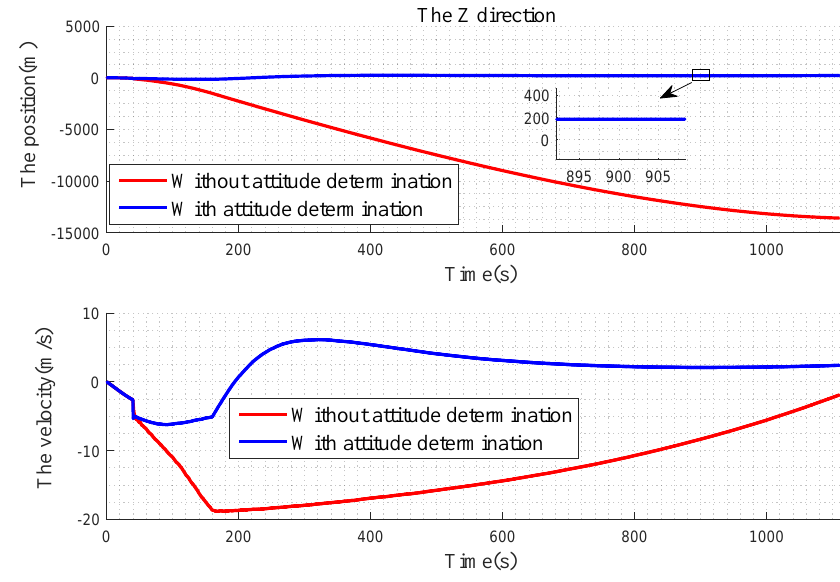
Figure 14. Precision comparison of the Z direction.